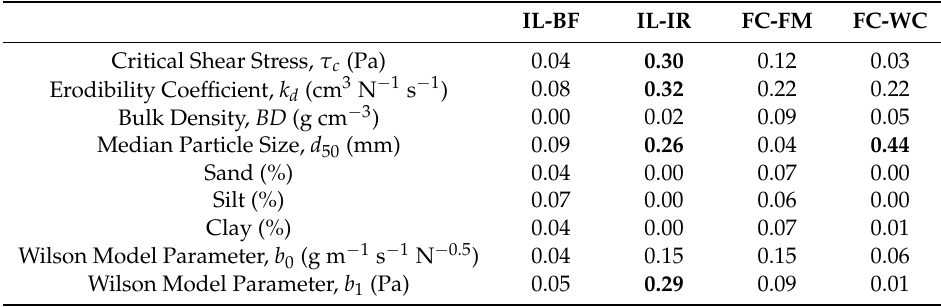
Note: Bold indicates significance at α = 0.05.